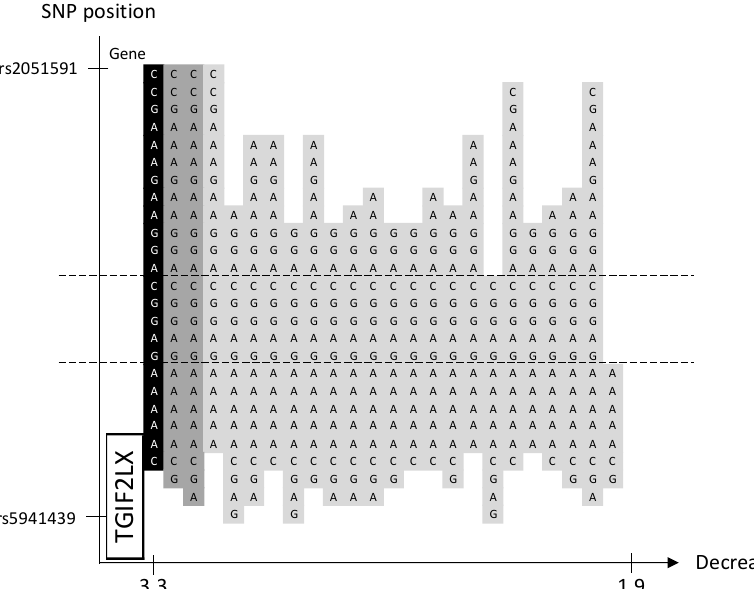
Figure 5. Chromosome X, 3 significant and 21 borderline significant haplotypes sorted by OR. The haplotype with the lowest p -value is marked in black, other significant haplotypes in dark gray and borderline significant in light gray. SNP position is on the y -axis. Gene position for TGIF2LX is indicated along the y -axis. The corresponding OR is on the x -axis. The dashed lines indicate the proximal and distal SNP that are shared by the significant and borderline significant haplotypes.